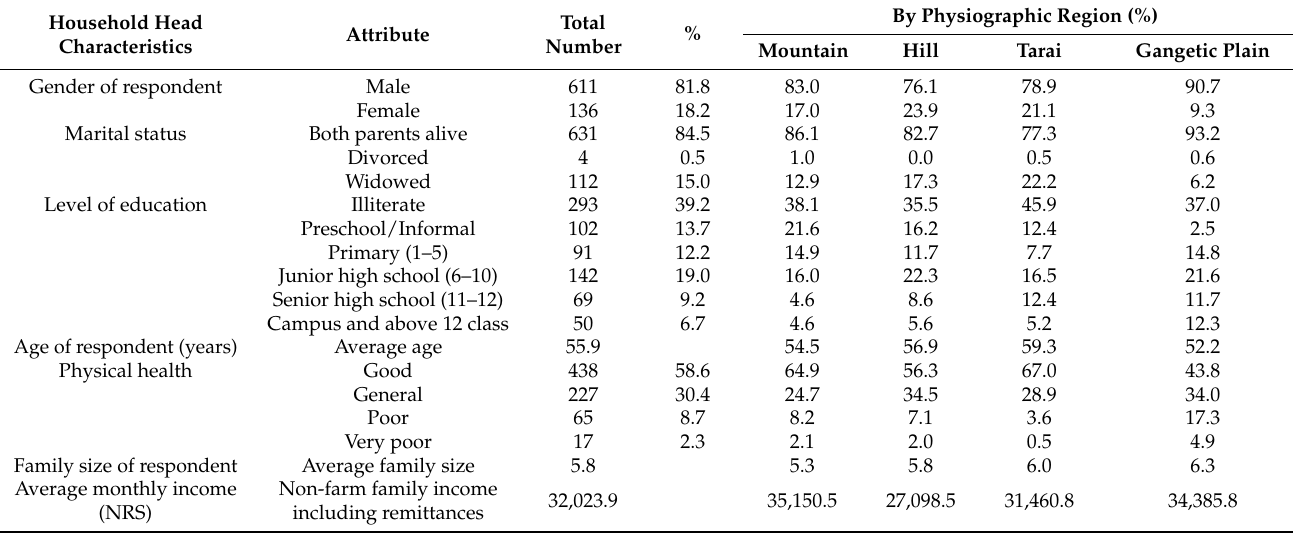
Table 4. Attributes for heads of household for the farmers surveyed in the trans-boundary KRB. Household Head